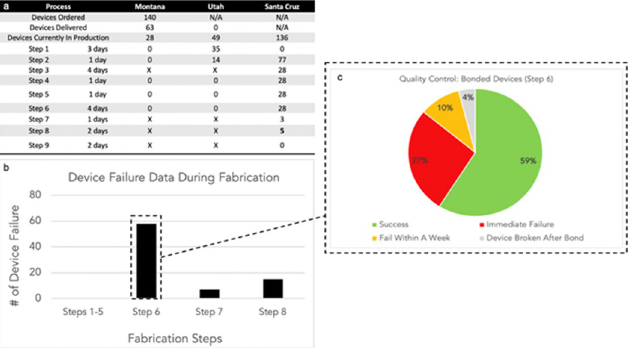
Fig 5. Data obtained from QR code tracking system. (a) Table displaying total quantity of devices in production and current fabrication steps, (b) Graph showing the number of device failure during fabrication process, (c) Pie chart conveying quality control statistics on step